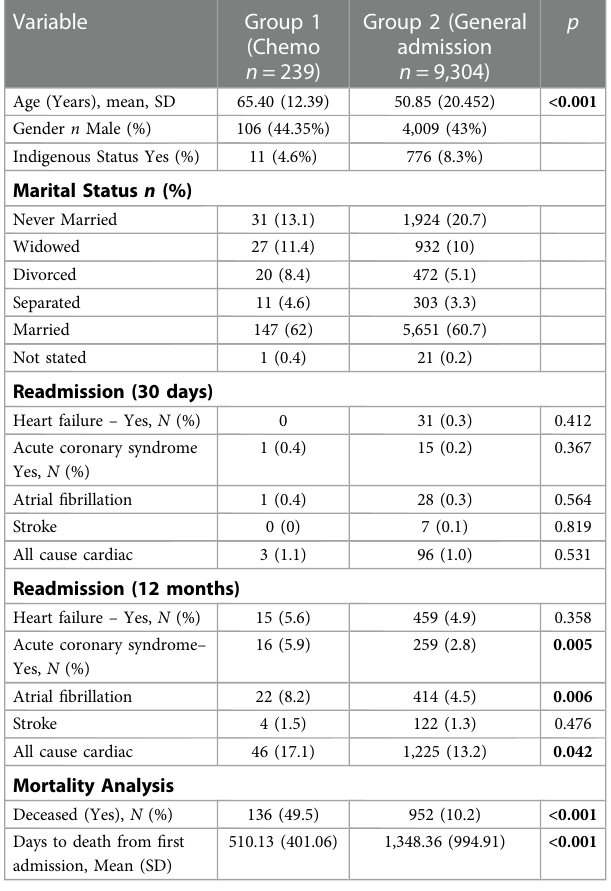
TABLE 2 Baseline patient characteristics: chemotherapy infusion unit patients vs. general admission patients.